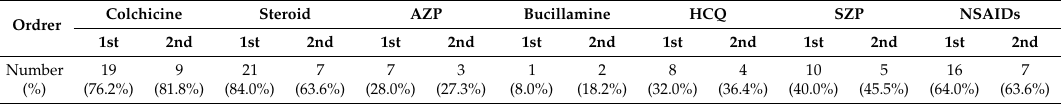
Table 2. Medication for patients with Behçet’s disease at blood